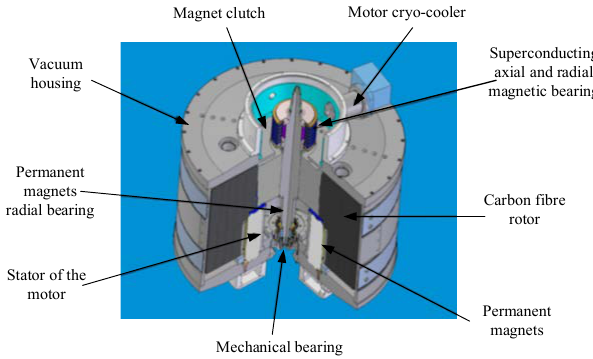
Fig. 2. Outline sketch of the 5 kWh/250 kW HTS